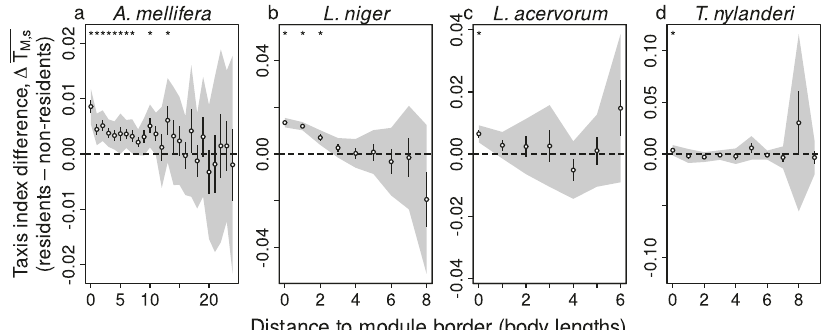
Fig. 5 | Quantifying directional bias toward the primary module. Panels a – d show the signed difference in the taxisindices of resident versus non-resident workers as a function of distance to the focal module border, for each species. Positive values occur when individuals from a focal module (residents) exhibit stronger taxis toward the nearest point on the border of that module than indivi- duals from other modules (non-residents). Vertical bars indicate standard errors,